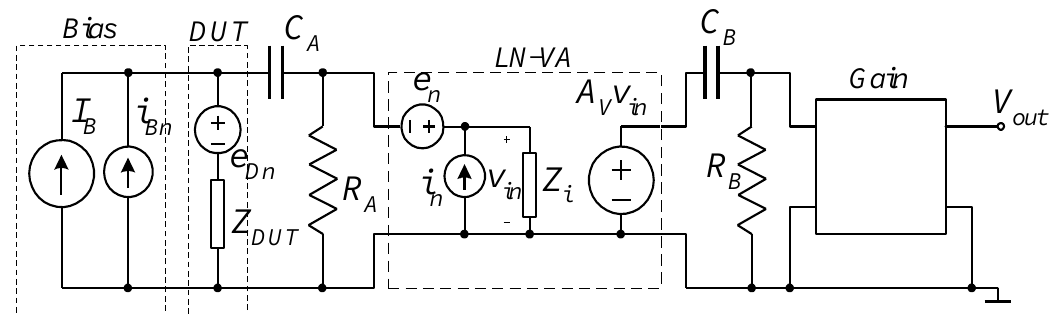
Figure 8. Block diagram of basic set up for voltage noise measurements.